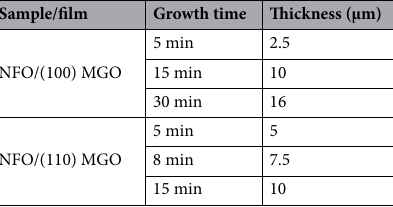
Table 1. Growth time and thickness of LPE grown NFO films on (100) and (110) MGO substrates.